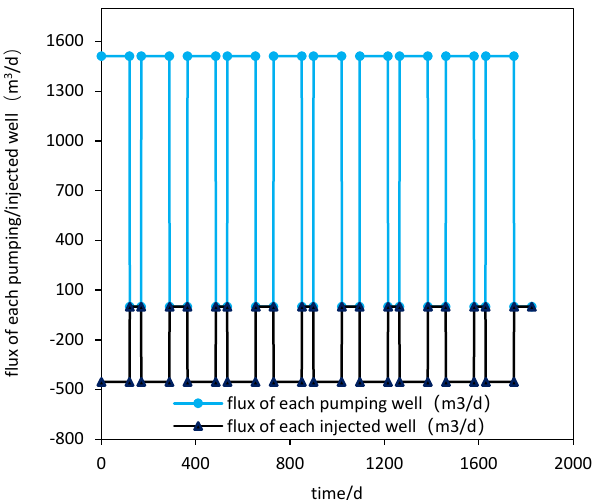
Figure 4. The flux of each pumping/injection well vs. time for the simulation schemes of the SGE system.